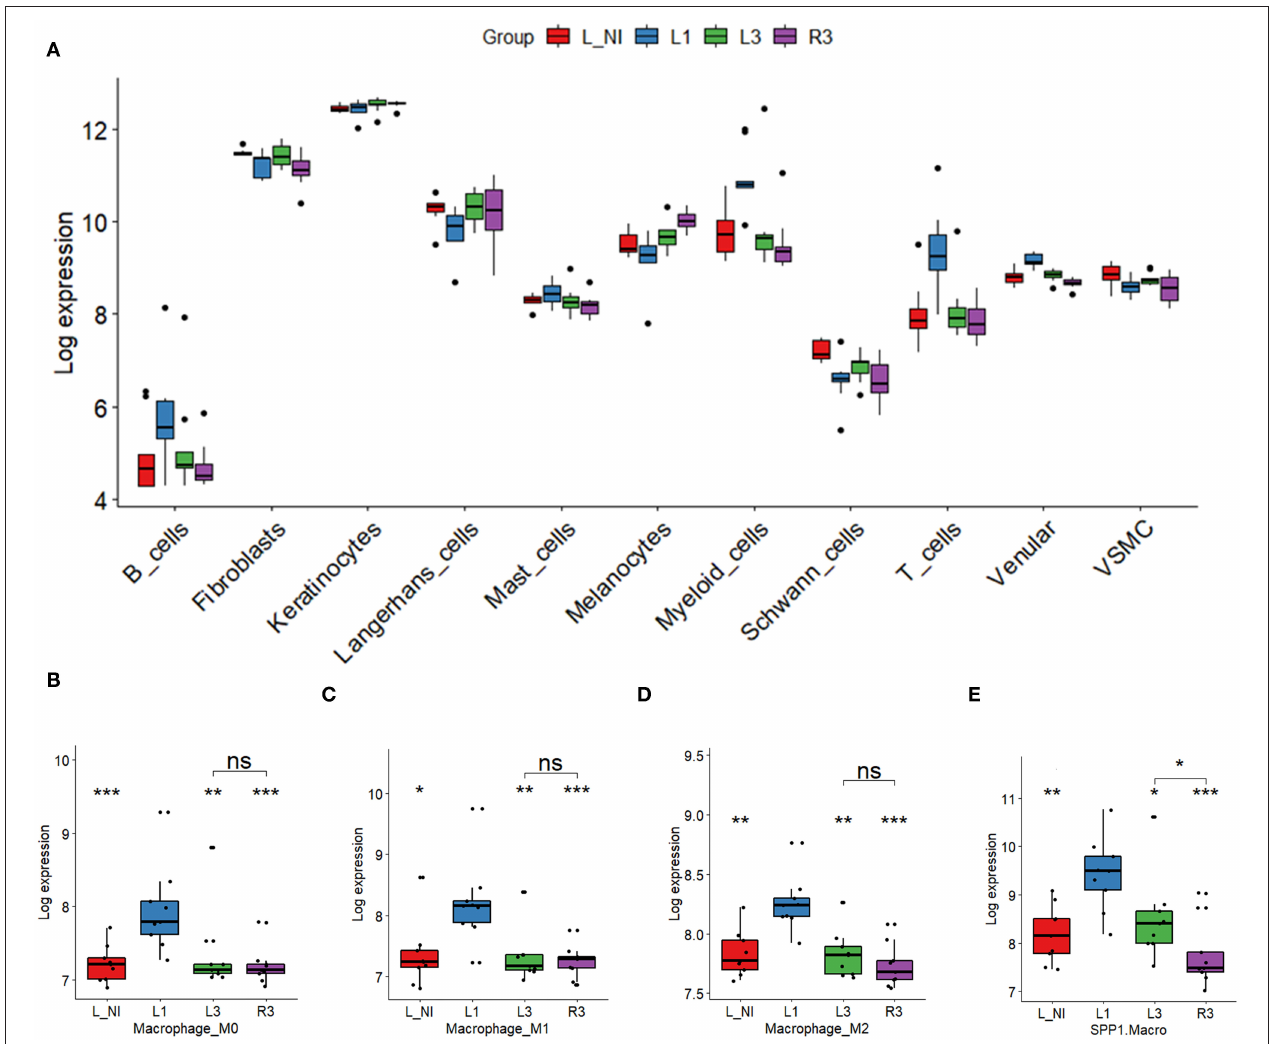
FIGURE 3 | Cell-type-specific gene signatures distribution. (A) Overview of changes in expression for major cell types present in skin biopsies. (B–E) Changes in expression levels of marker genes associated with different classes of macrophages. *Represent the statistical significance of the difference in gene expression when comparing non-involved skin (L_NI), with acne papule (L1), spontaneously resolved papule (L3), or Trifarotene treated skin (R3). While expression of each class of macrophages is reduced when compared to papule signature, only SPP1 activated macrophages show a significant difference when compared to spontaneous resolution of acne papule. For each sample, an expression score was derived from selected marker genes for each cell type. Changes in expression in each clinical group were represented using boxplots. ns, non-significant; * p < 0.05; ** p < 0.01; *** p < 0.0001.